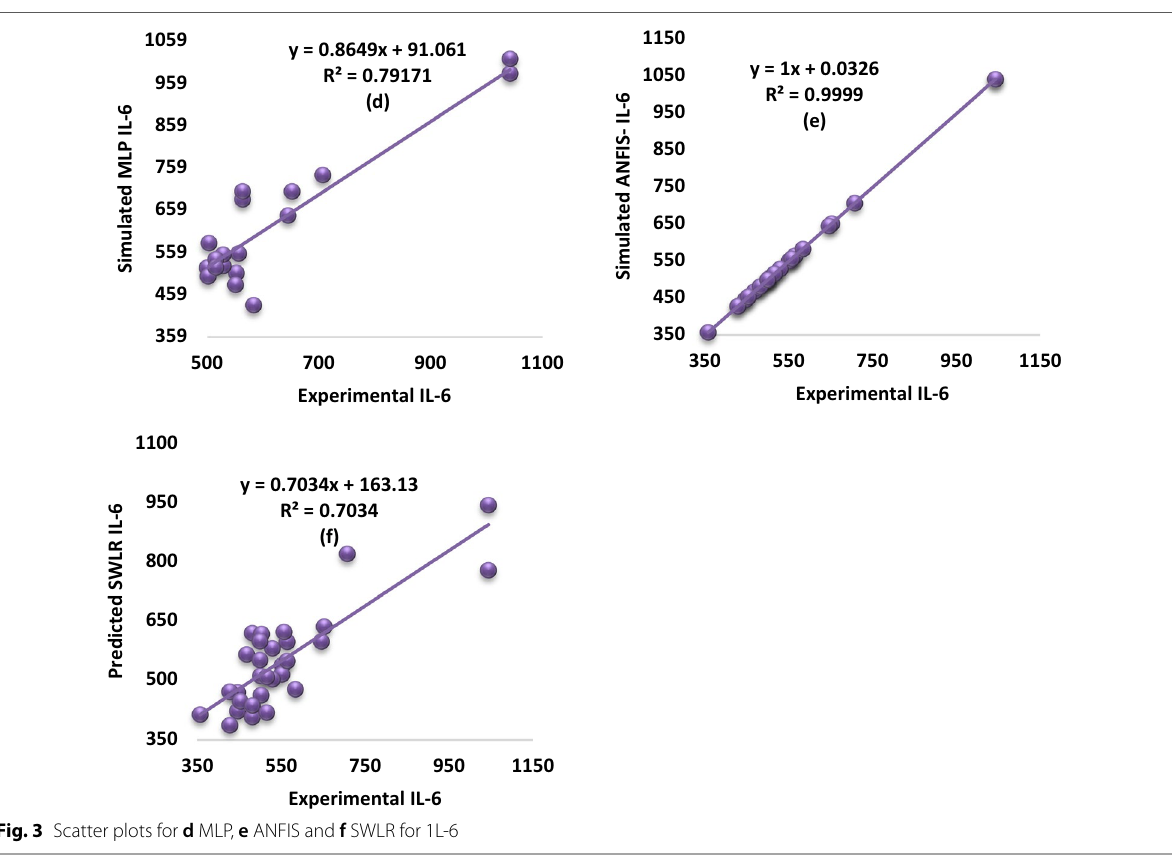
The best performing model are written in bold